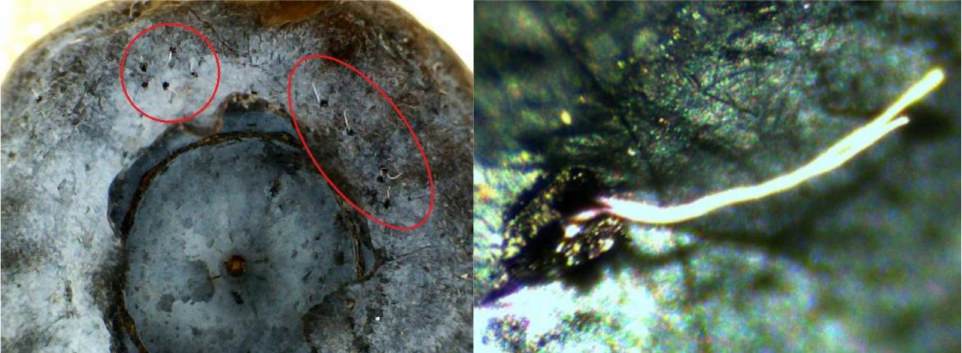
Figure 2. Highbush blueberry fruit infested by D. suzukii . ( Left ) Regions marked in red contain scars with visible filaments. ( Right ) Microscopic image of the oviposition site with visible pair of